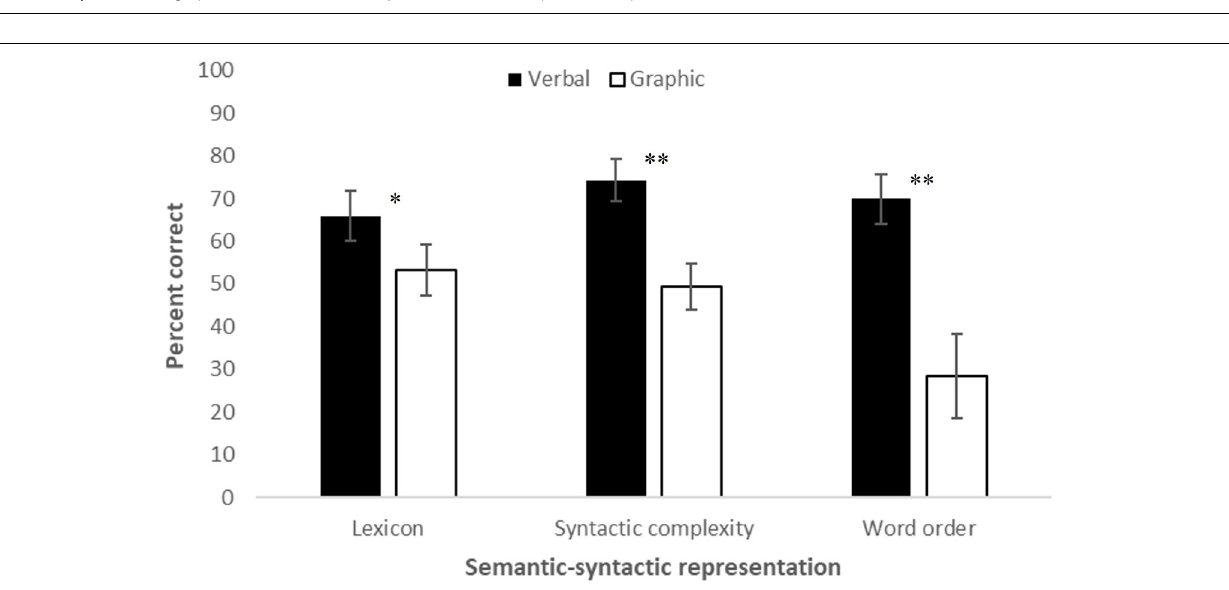
FIGURE 1 | Verbal and graphic scores for different syntactic structures. † p = 0.05; ∗∗ p < 0.001.